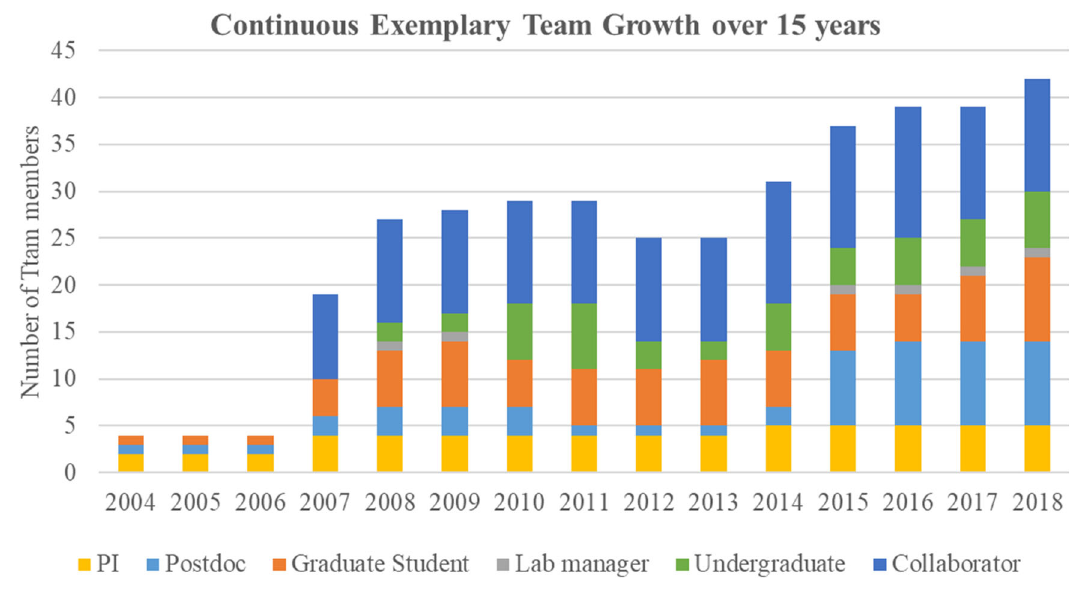
Fig. 2 Continuous exemplary team growth over 15 years. The team grew from 4 members in 2004 to 42 members in 2018. Much of the growth occurred by the addition of students and external